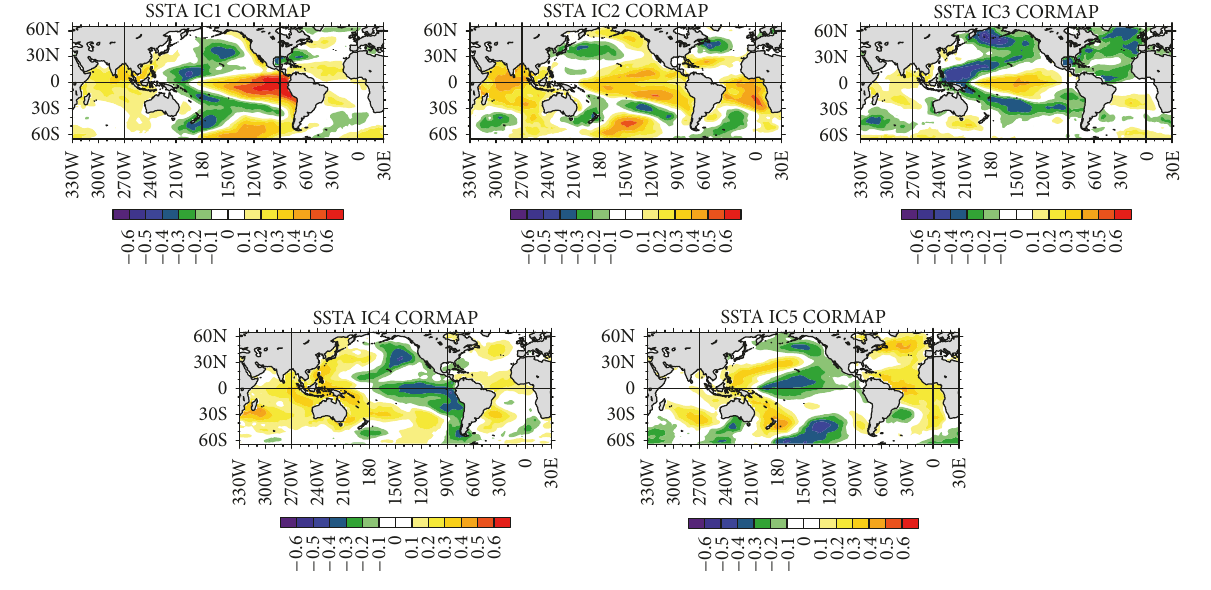
Figure 11: Correlation maps between ICs and SSTA field.